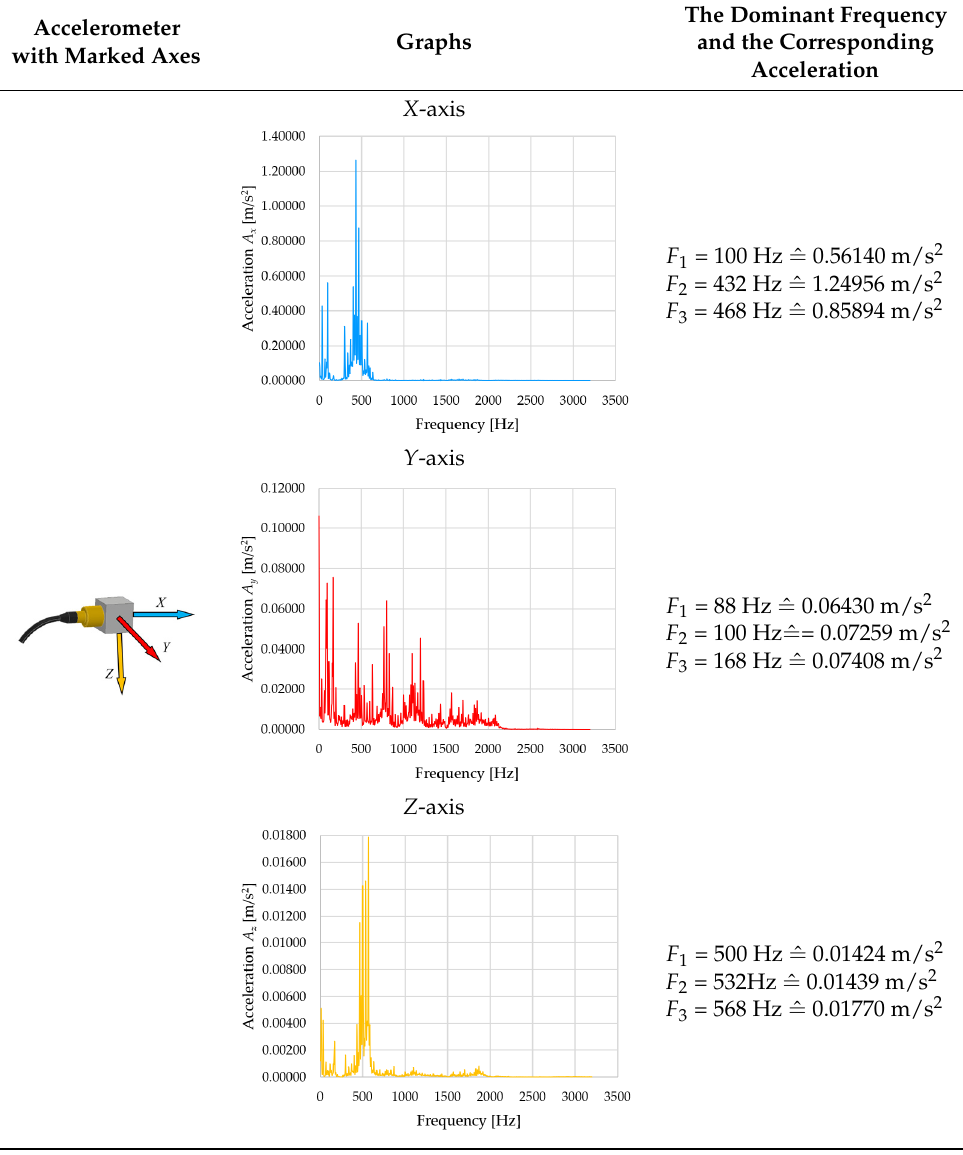
Table 5. The course of acceleration depending on the frequency for velocity 100 % (131.0°/s).